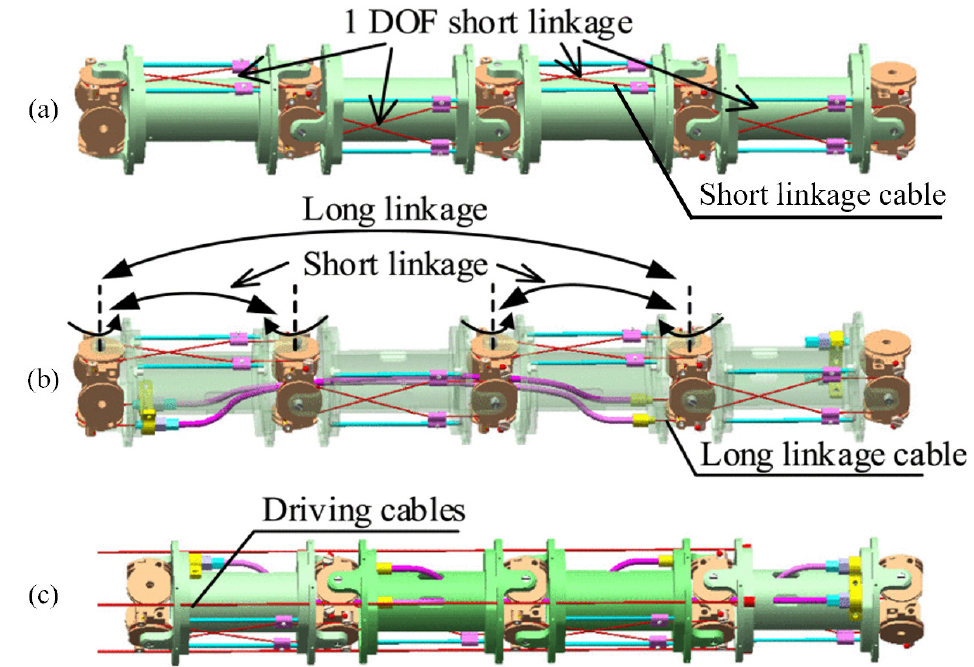
Figure 2. Short linkage, long linkage, and linkage segment. ( a ) Short linkage. ( b ) Long linkage. ( c ) Overall active and passive linkage